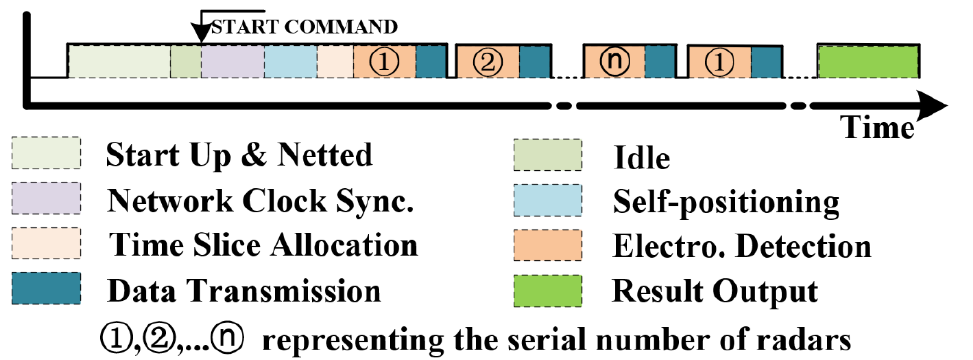
Figure 3. The workflow timing.